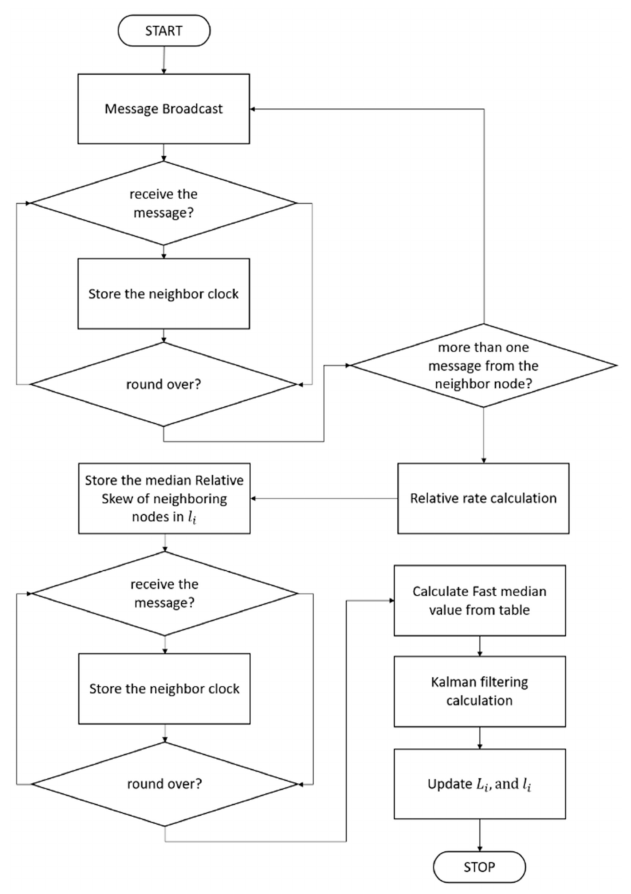
Figure 5. Flowchart of the whole process of